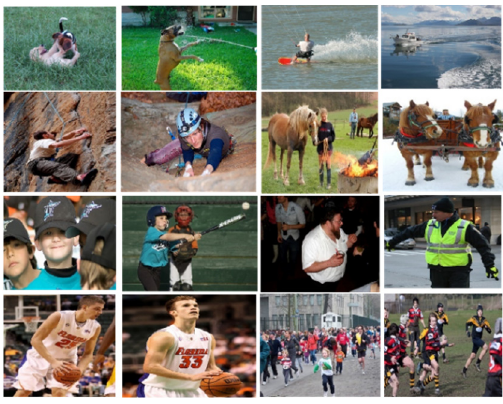
Figure 12. Examples of the Flickr8k dataset [30].